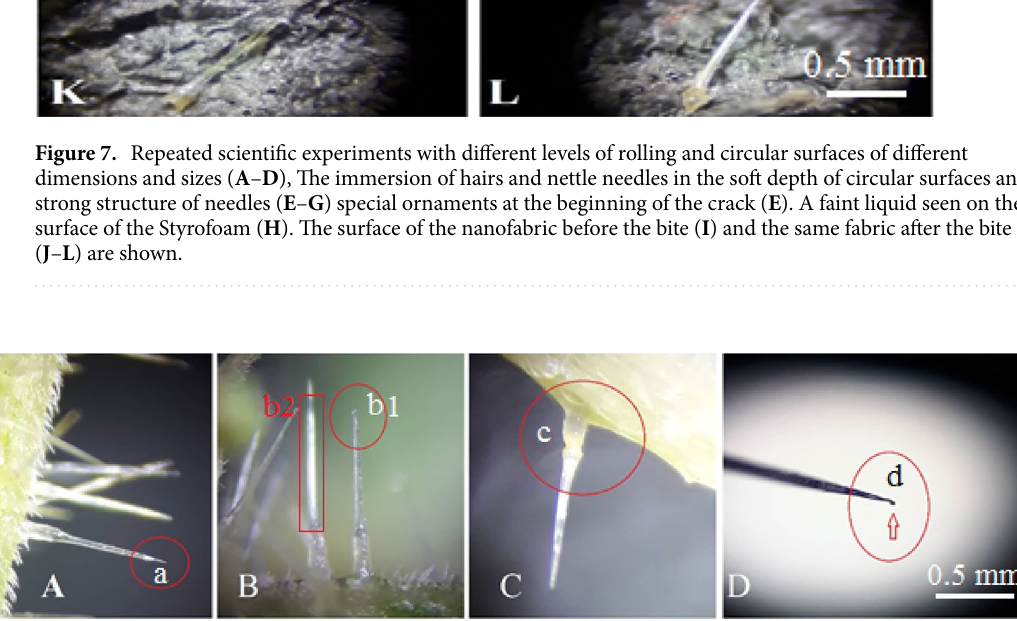
Figure 8. Morphological details of stinging hairs and their distribution on the surface of the tissue. Most of them have three parts: a poison tank (c), a needle or injection tube (b2), and a special brittle tip marked with a red circle (b1&